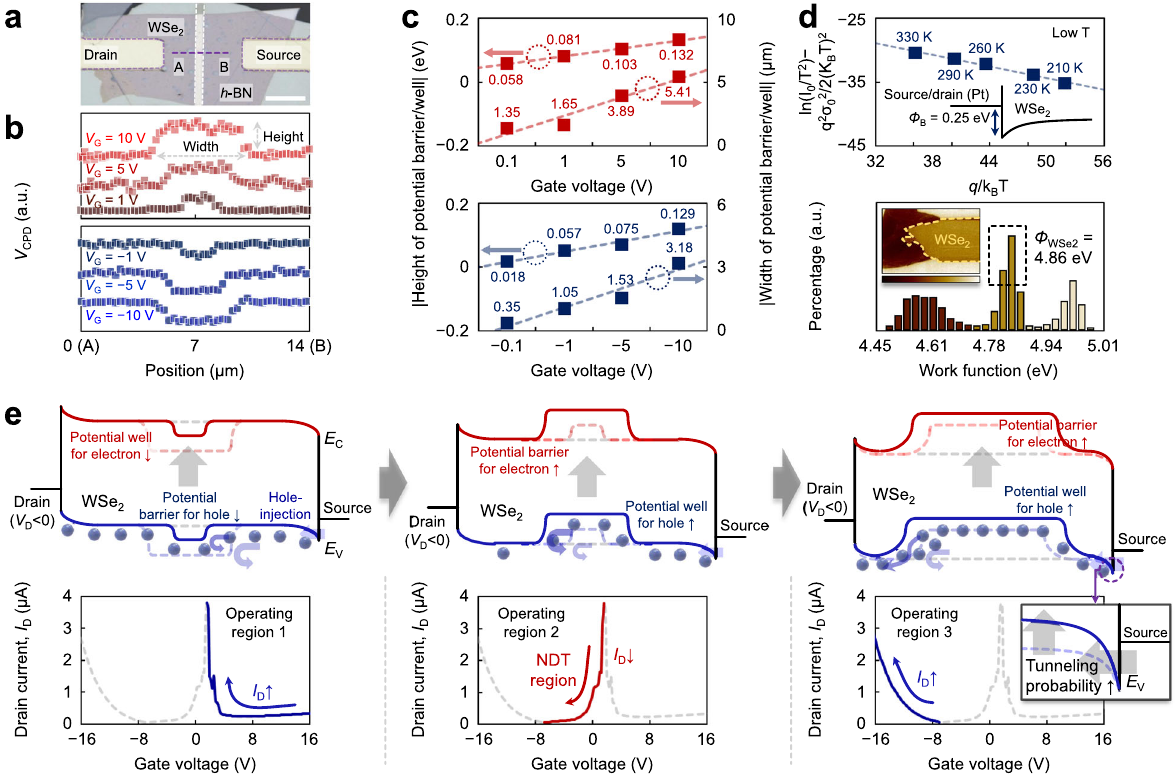
Fig. 2 In-depth analysis of the NDT phenomenon. a OM image of the PG-NDT device for KPFM analysis, where the length of the scale bar denoted in the OM image is 10 μ m. b V CPD pro fi le from points A to B under the positive and negative V G values. c Height and width of the potential barrier and/or well, which were extracted under the positive and negative V G values. d Modi fi ed Richardson plot of the PG-NDT device (top) and distribution of Δ V CPD extracted from the inset KPFM mapping image (bottom). e Energy band diagrams and I D − V G curves of the PG-NDT device at three different gate voltage regions. From V G = 20 V to the vicinity of V G = 0 V (left), from the vicinity of V G = 0 V to the vicinity of V G = − 10 V (middle), and from the vicinity of V G = − 10 V to V G = − 20 V